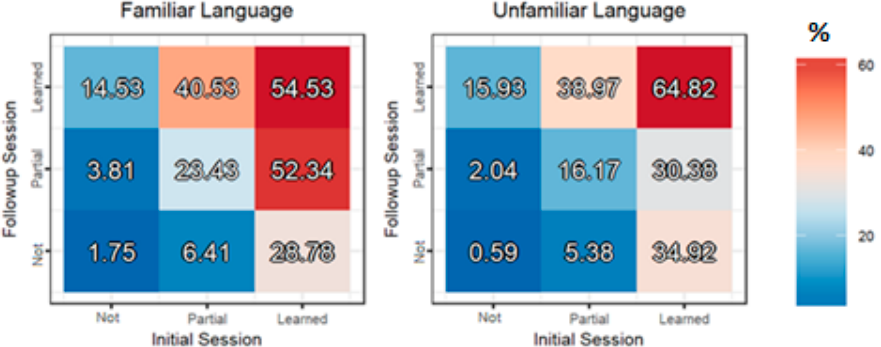
Figure 3. Surprise recall test accuracy (%) based on learning in the initial (first) and follow-up (second) training sessions divided by language group, with the familiar language on the left and the unfamiliar language on the right.